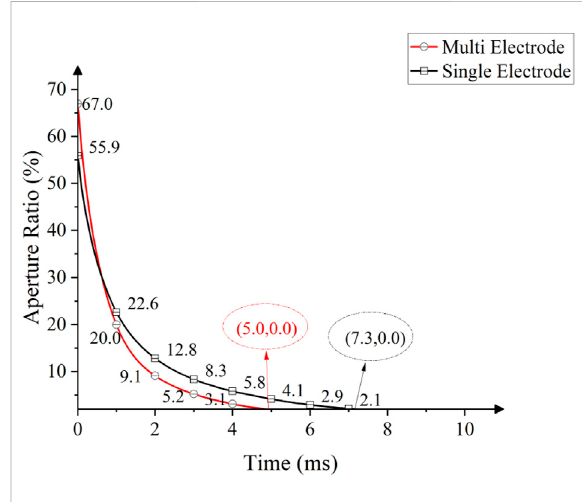
FIGURE 5 Aperture ratio corresponding to arc multi-electrode and single-electrode as a function of time in the pixel closing stage. Each curveconsisted of 70 data points with an interval of 0.1 ms.A 15 V boosting voltage was applied to the sub-electrode 4 in the arc multi-electrode, but none at the single-electrode. The oil in the single-electrode was naturally recovered.